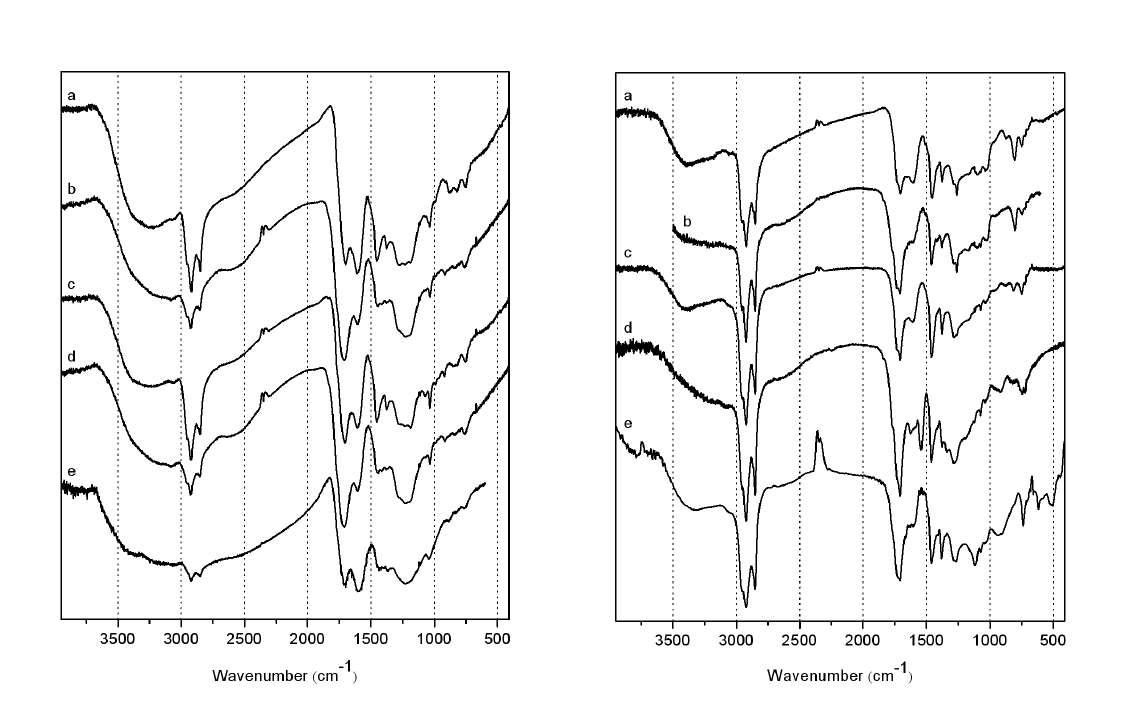
Fig. 6 FTIR spectra of CH 2 Cl 2 extracts: (d) 5 % HNO 3 , (e)